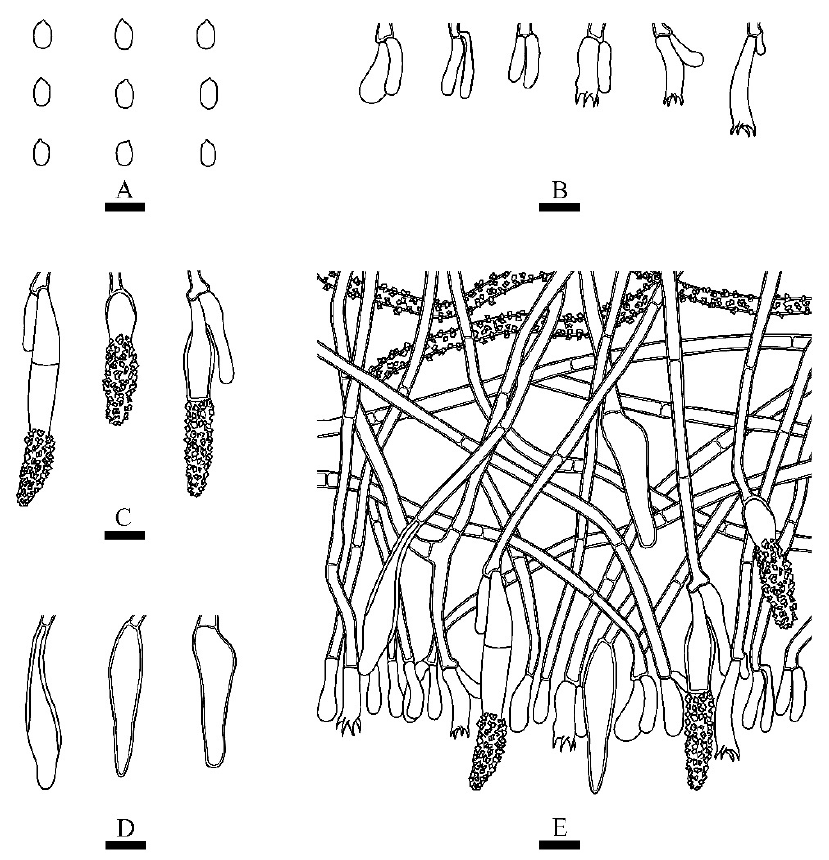
Figure 6. Microscopic structures of Rhizochaete grandinosa (holotype): ( A ) basidiospores; ( B ) basidia and basidioles; ( C , D ) cystidia; ( E ) a section of hymenium. Bars: ( A ) = 5 µm, ( B – E ) = 10